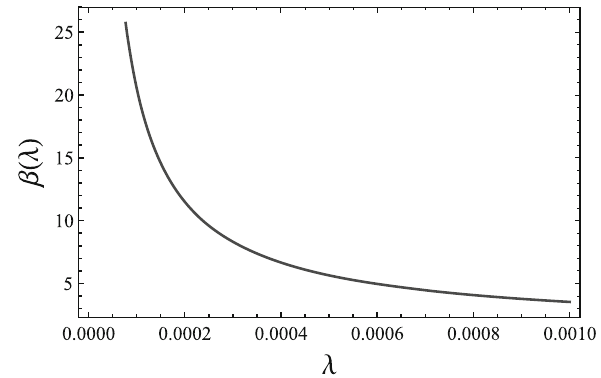
Fig. 1 The plot illustrates the values of threshold parameter β as a function of the perfect fluid dark matter parameter λ in the case of fixed (cid:11) = 0 . 01. Note that beyond the threshold value of β the black hole always favors no overcharging even under linear order